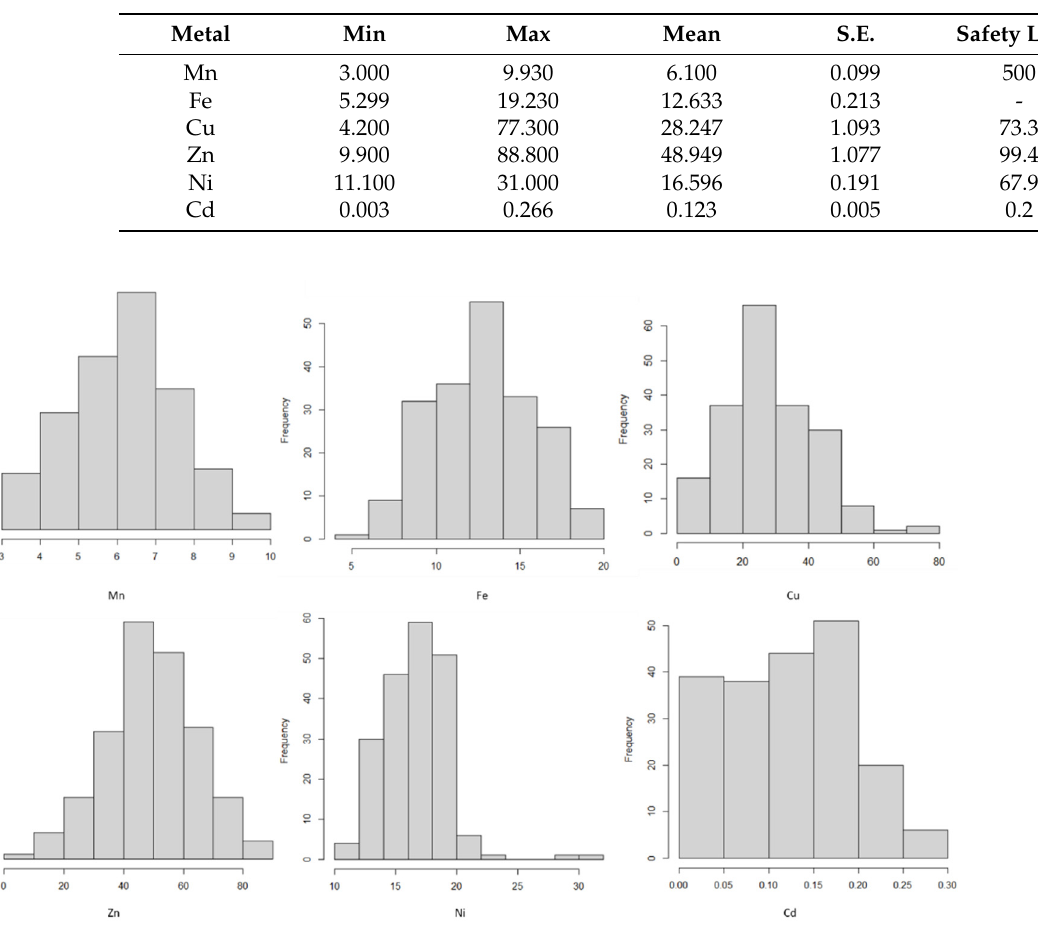
Figure 1. Frequency distributions of non-normalised metals values for the WAMI population. Vertical axes indicate the number of lines per trait value class, and horizontal axes indicate the different trait value classes.